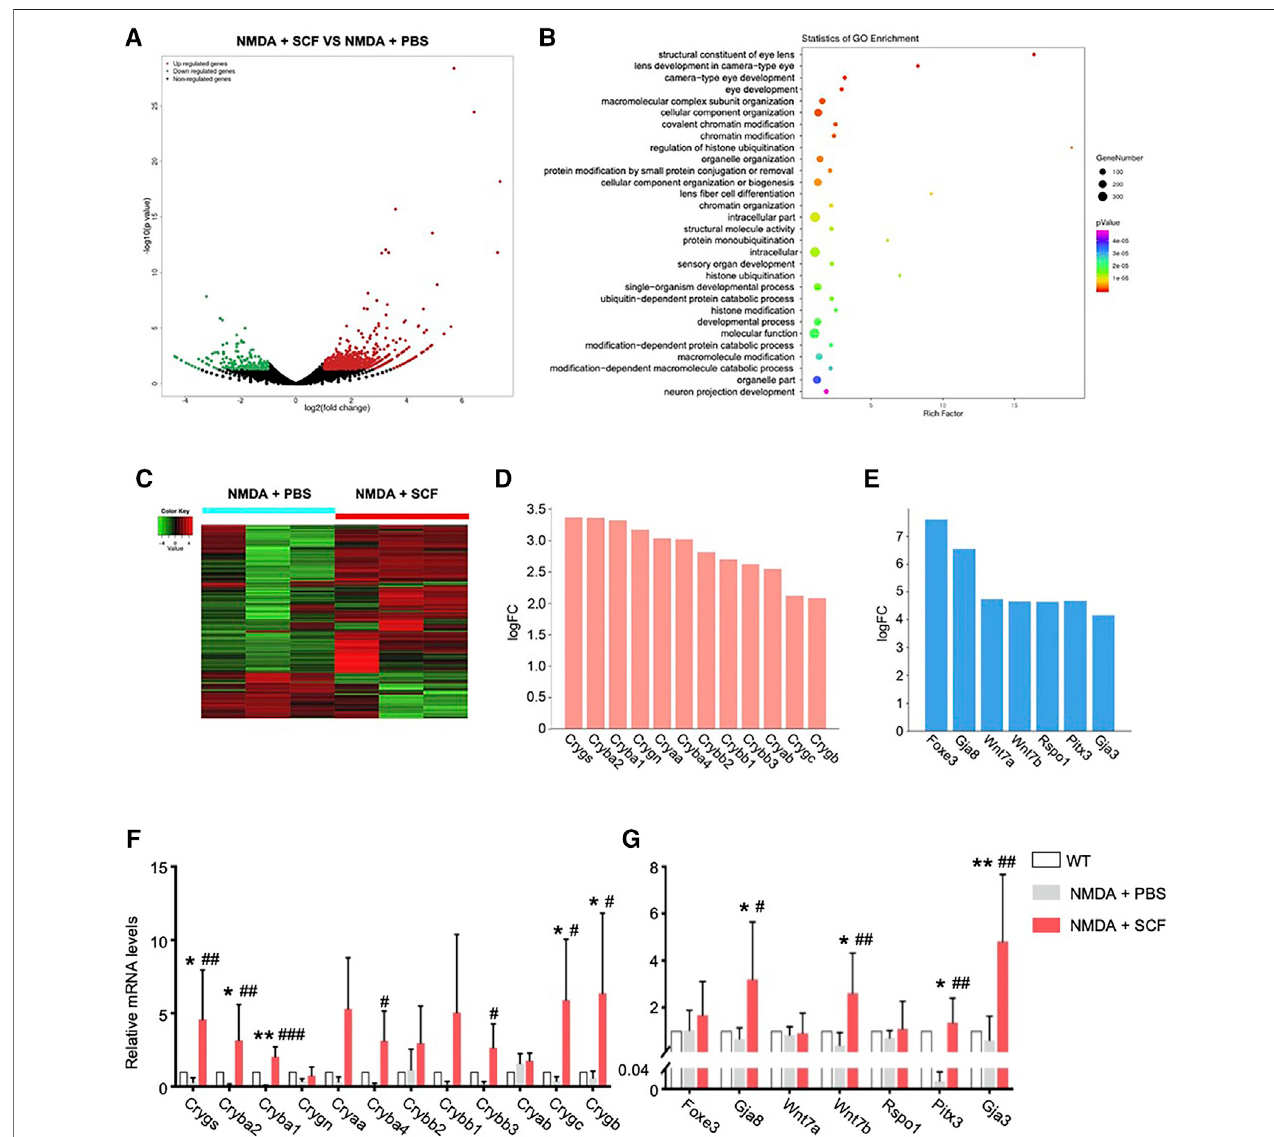
FIGURE7| RNA-seqRevealedtheInvolvementofKeyGenesforSCFTreatment. (A) Volcanoplotofdifferentiallyexpressedgenes(DEGs)inSCFgroupcompared with controls after 1 week treatment. (B) Gene Ontology (GO) analysis showing the enriched gene functions of SCF group versus control group. (C) Heatmap analysis showing DEGsin indicated groups. The relative abundance ofeach genus was indicated byagradient ofcolorfrom green(low abundance) tored (high abundance). (D) Crystallins family members were signi fi cantly up-regulated in SCF treated retinas. (E) Among top10 DEGs in SCF exposed mice, several neuro-protective factors were up-regulated, including Wnt7 related genes, Foxe3/Pitx3 , and gap junction protein coding genes Gja8 / Gja3 . (F) Real-time qPCR analysis showing relative mRNA expression for the Crystallins family members among WT, NMDA +PBS and NMDA + SCF treated mice after 1 week. (G) Real-time qPCR analysis con fi rming the expression for the genes highly expressed in RNA-seq analysis. Data were shown as mean ± SD ( n = 5 for each time point). * p < 0.05, ** p < 0.01, compared with WT mice, # p < 0.05, ## p < 0.01, ### p < 0.001, compared with the NMDA + PBS group.